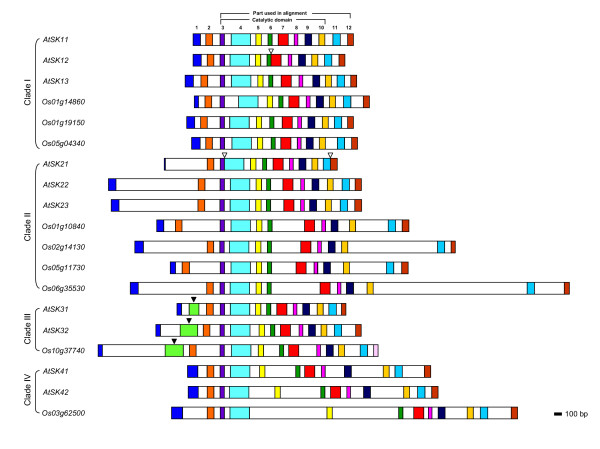
The gene structure of ten Arabidopsis and nine rice GSK3/SHAGGY-like kinase genes. The positions of the introns within the coding region are mostly conserved among Arabidopsis and rice GSK genes, except AtSK12, AtSK21, AtSK31, AtSK32, and Os10g37740, which either lack an intron or an exon or have additional exons. Open triangles indicate the absence of an intron. Closed triangles indicate additional exons. Boxes of identical color among sequences represent exons of the same approximate size and relative position.